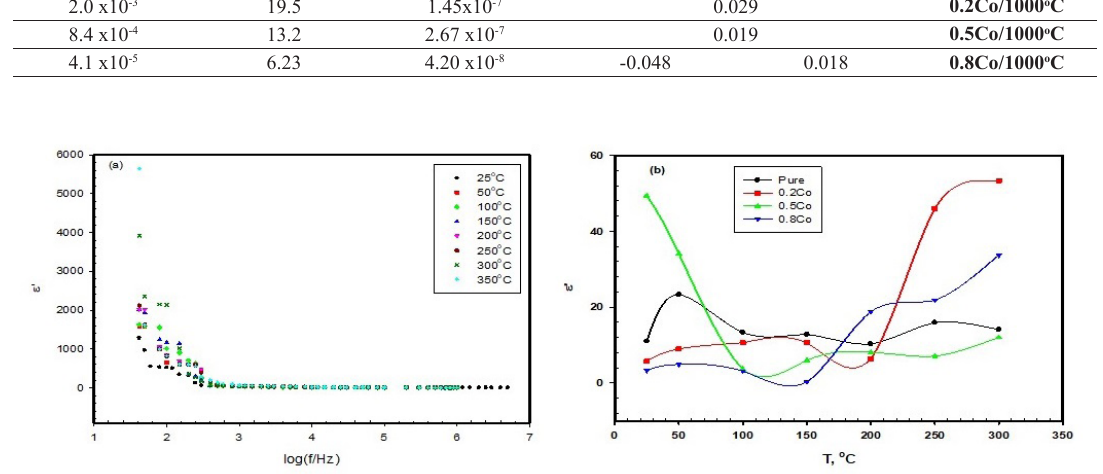
Figure 9. (a) The frequency and temperature dependence of the dielectric constant (έ) for pure Zn-ferrite prepared by microwave method at 1000 o C (b) The dependence of dielectric constant on the composition and temperature at 100Hz.